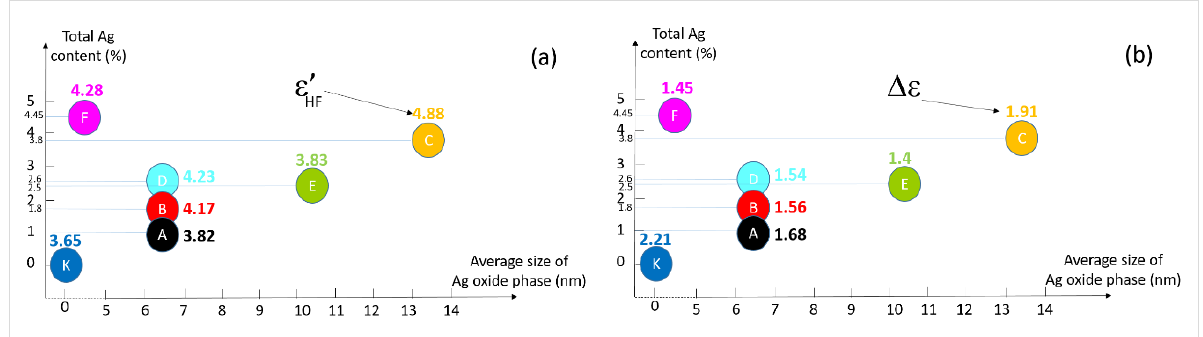
Figure 7: The amount of silver-oxide nanoparticles as a function of their average size. Additional information next to the sample symbol and in the same color of sample symbol: a) the high-frequency dielectric constant ε ’ HF (value at 1 MHz); b) the dielectric strength Δε .